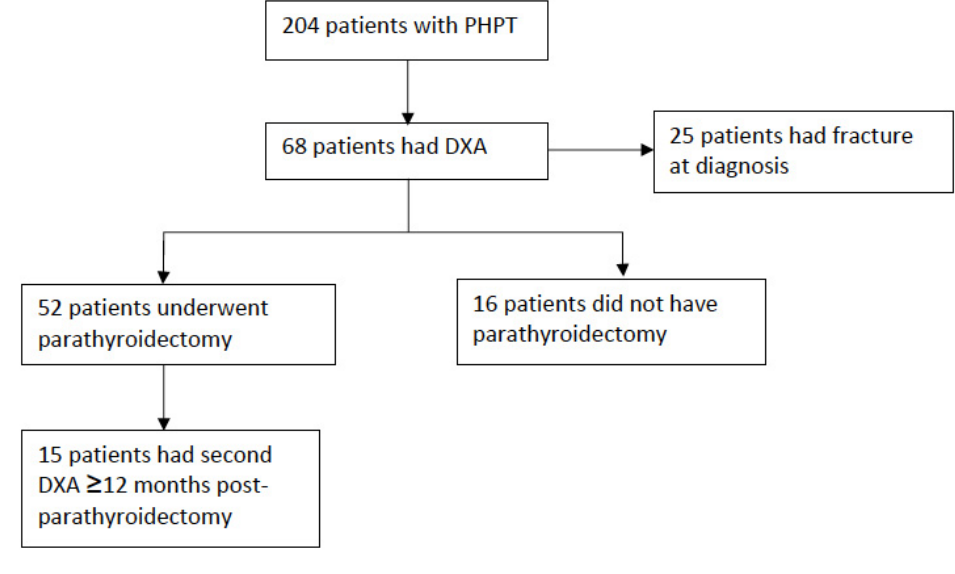
Figure 1. Study Figure 1. Study cohort. Table 1. Demographic data.